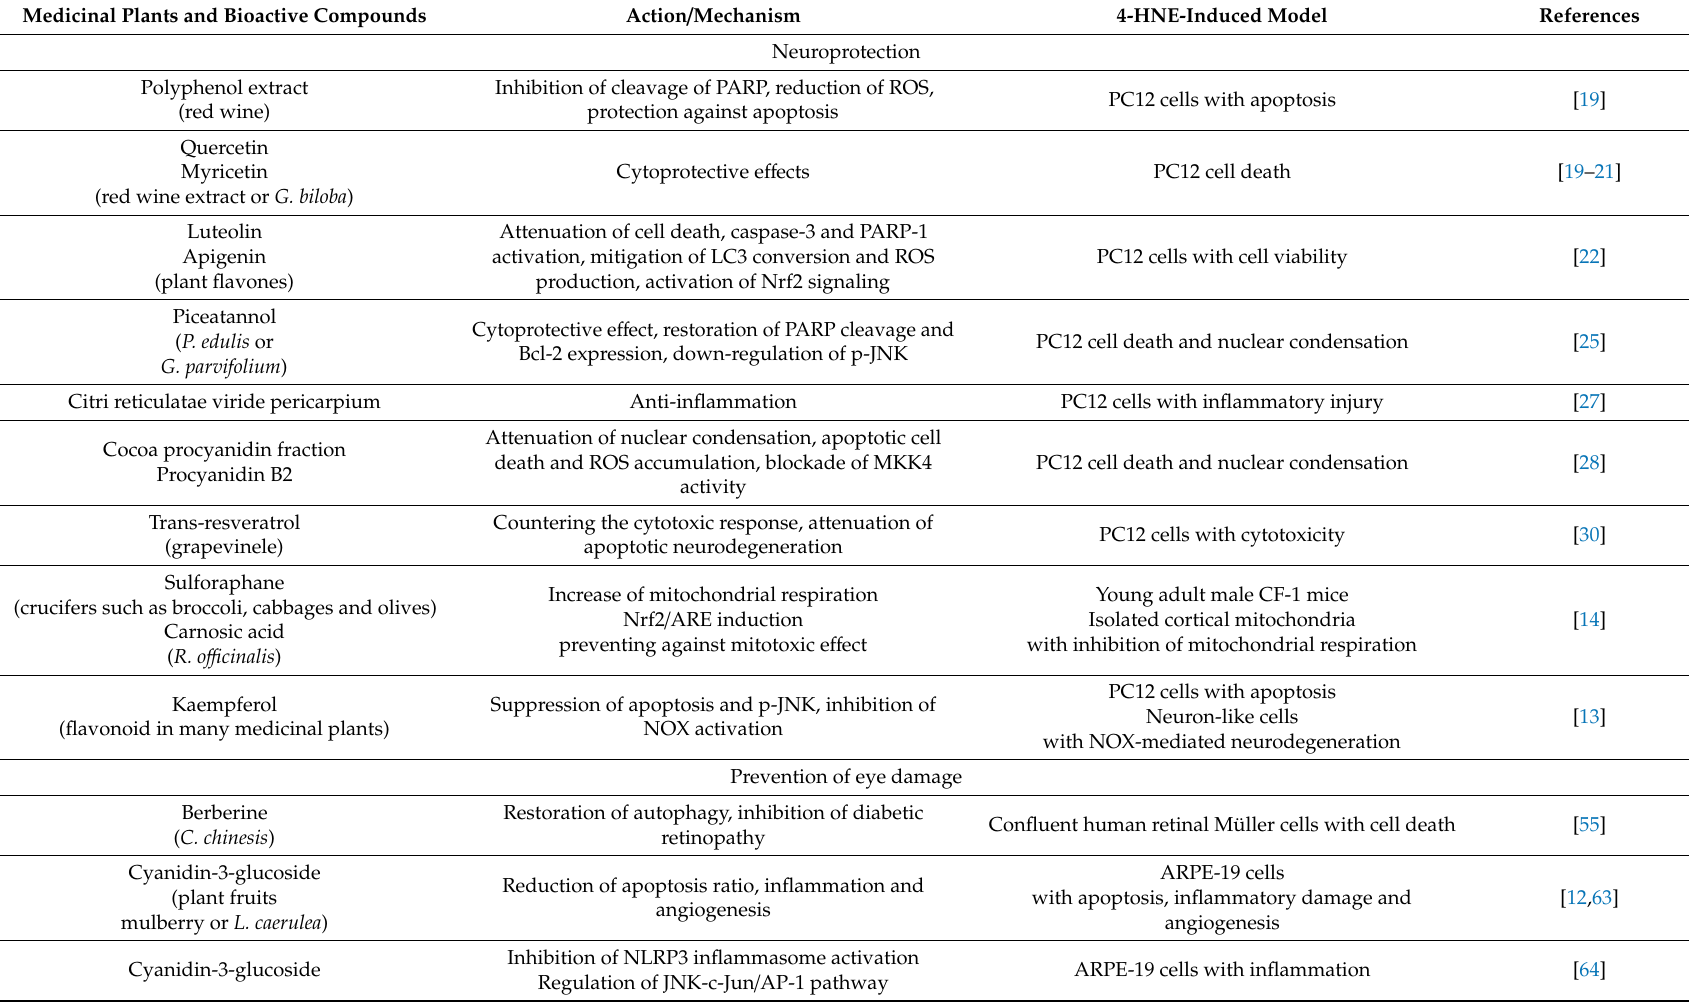
Table 1. Medicinal plants and bioactive compounds in the attenuation of 4-HNE-induced deleterious e ff ects. Medicinal Plants and Bioactive